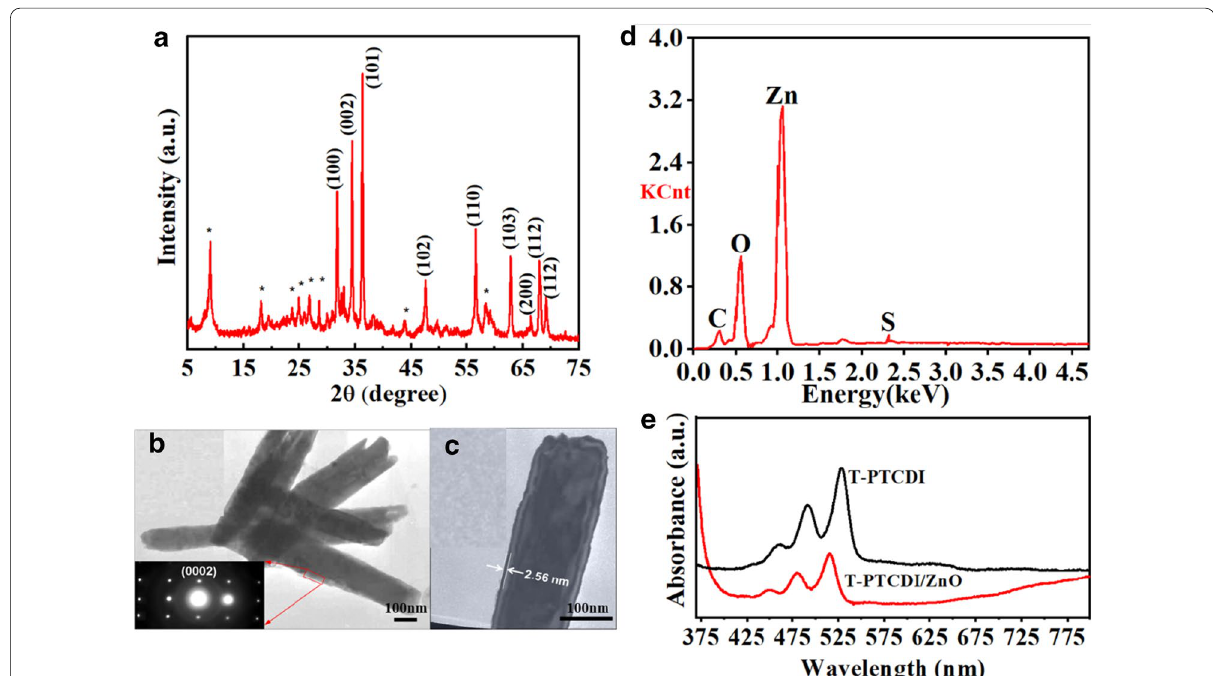
Fig. 3 a XRD diffraction pattern for ZnO-T-PTCDI composite. TEM of composite material of ZnO-T-PTCDI: b low magnification, inset: Selected Area Electron Diffraction Pattern (SAED) and c high resolution. d Energy spectrum analysis of ZnO-T-PTCDI composite. e UV–visible spectra of T-PTCDI and T-PTCDI/ZnO nanorod